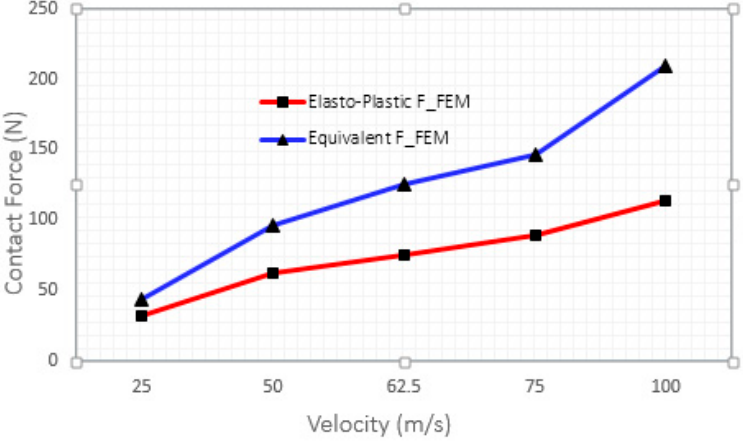
Figure 6. A plot of the contact force in FEM and the equivalent contact force from the DEM needed for plastic deformation in FEM at various shot velocities.